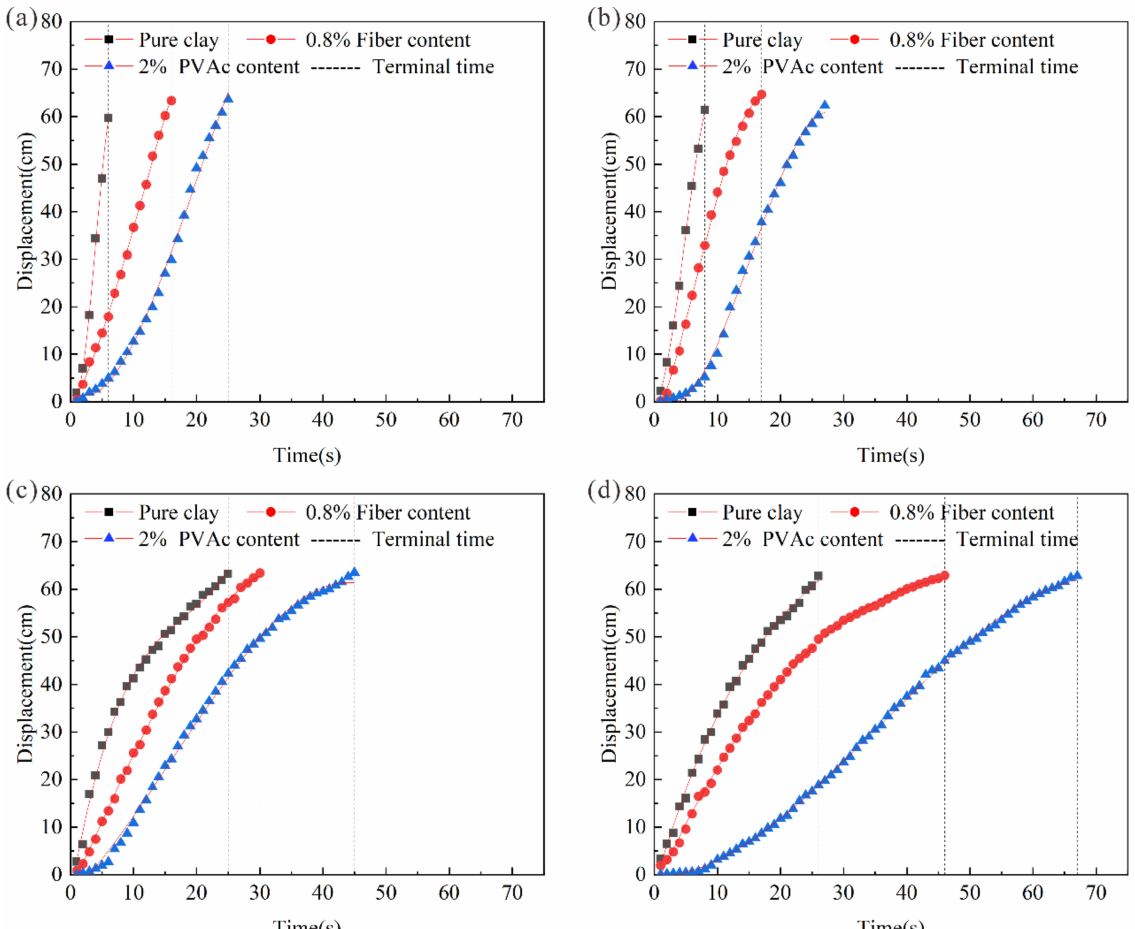
Figure 6. Time displacement curve at moisture contents of ( a ) 45%, ( b ) 40%, ( c ) 35%, and ( d ) 30%. Comparing the time-displacement curves of pure clay, fiber-reinforced clay, and